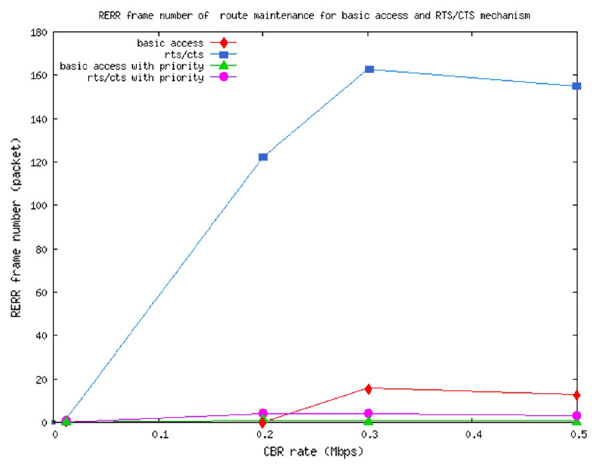
Fig. 8 RERRpacketnumberofroutemaintenanceinthe7-nodeschain